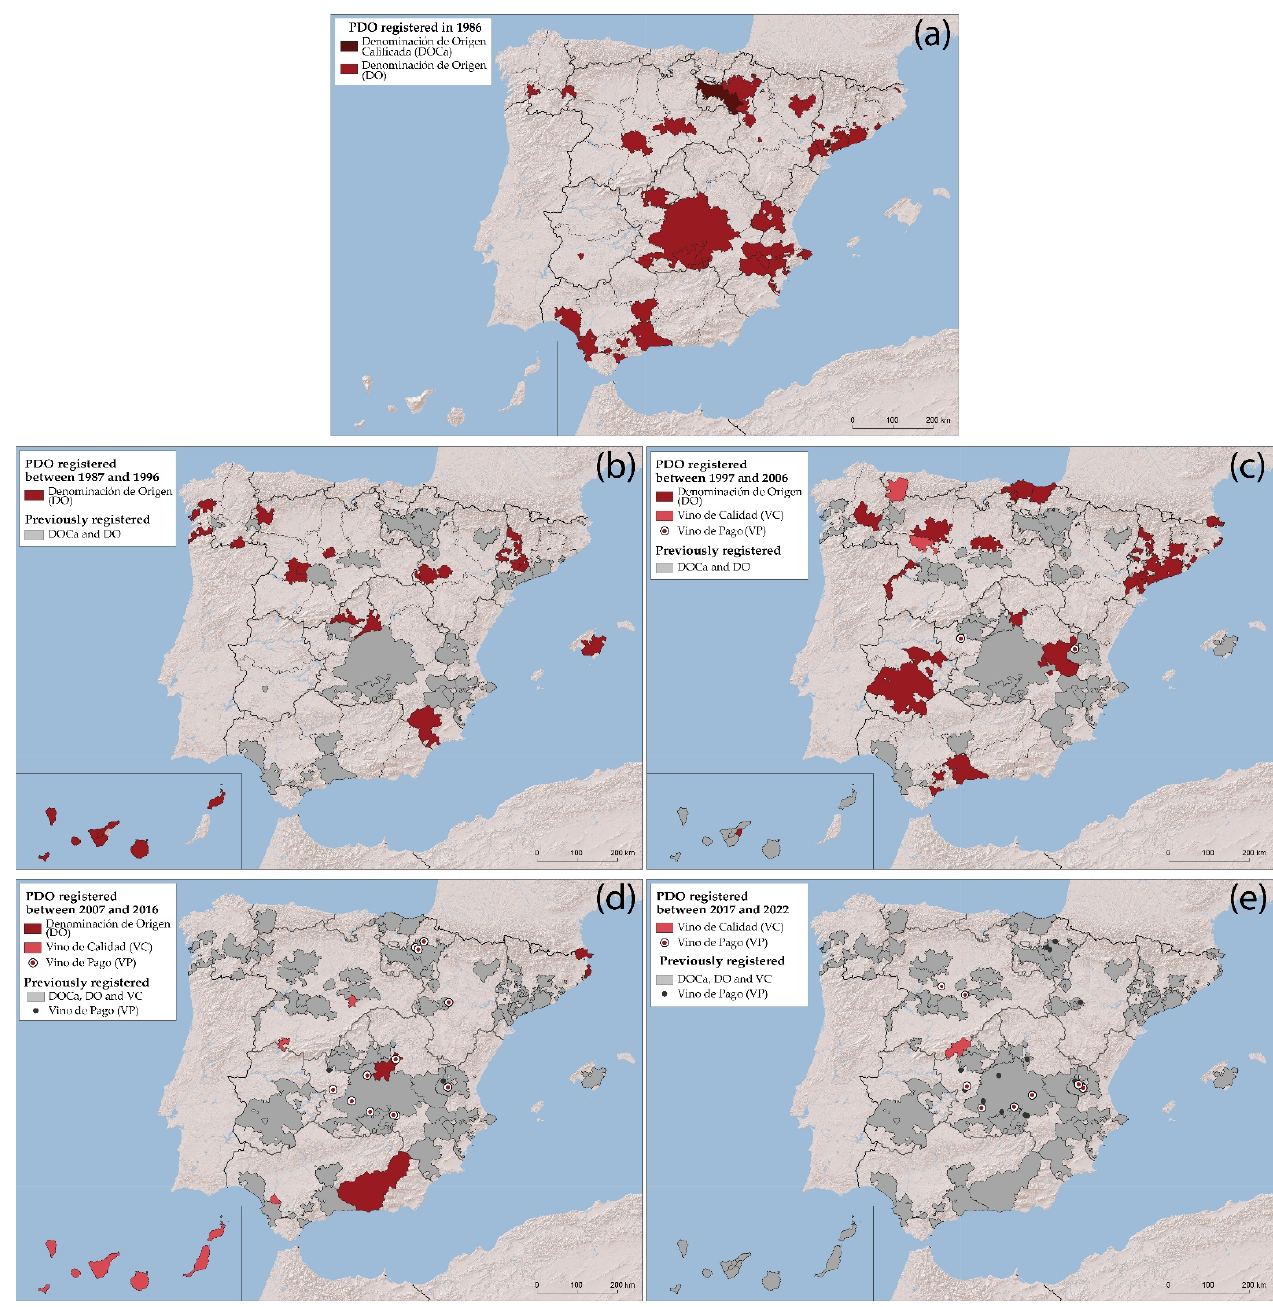
Figure 9. Evolution in the European registry of Spanish wine PDO (1986-2021).: ( a ) PDO registered in 1986, ( b ) PDO registered between 1987 and 1996, ( c ) PDO registered between 1997 and 2006, ( d ) PDO registered between 2007 and 2016, ( e ) PDO registered between 2017 and 2021. Source: European Commission. eAmbrosia. The EU geographical indications register. Retrieved from: https://ec.europa.eu/geographical-indications-register/ (accessed on 14 March 2022) and Spanish Ministry of Agriculture, Fisheries and Food. Own elaboration.